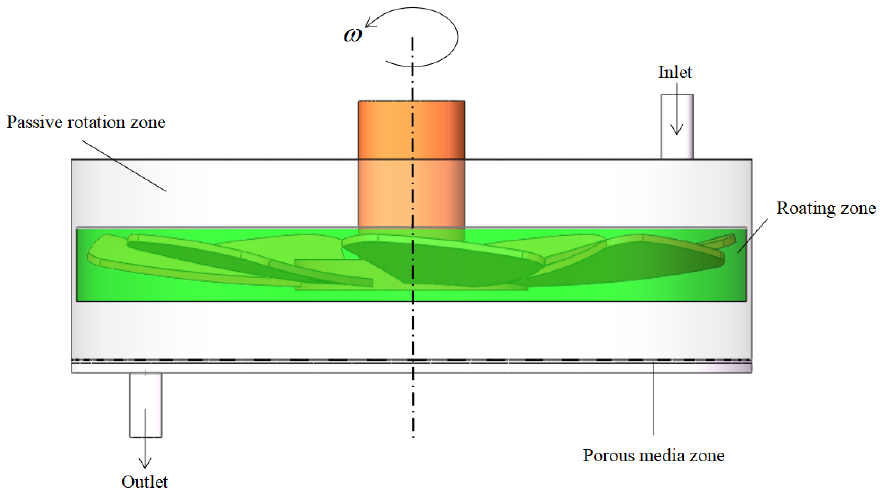
Figure 3. Settings of the geometric boundary